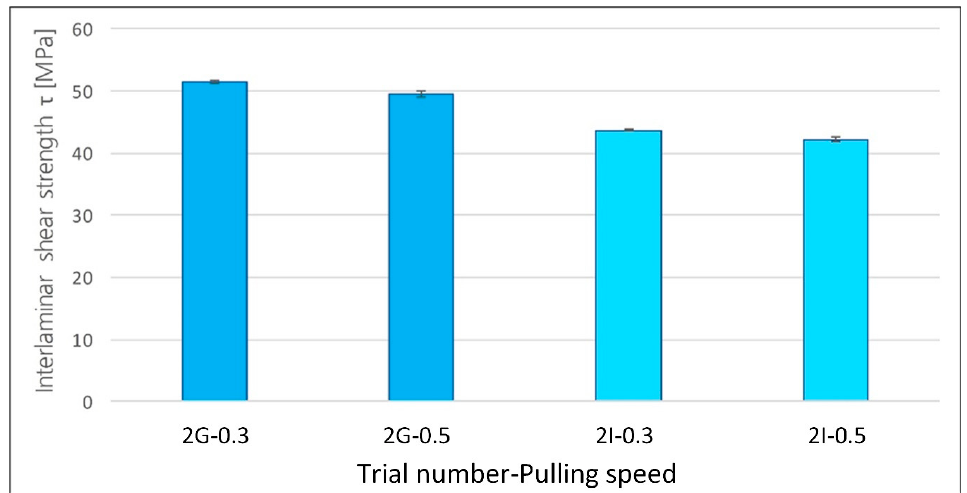
Figure 8. Interlaminar shear for different pulling speeds and resin mixing times .